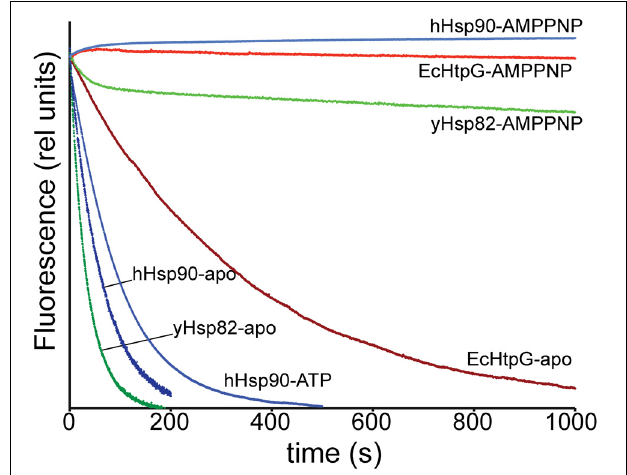
FIGURE 6 | Subunit-exchange rates differ significantly in Hsp90 proteins. Complexes of ATTO 488 and ATTO 550 labeled single cysteine variants of EcHtpG (red), yHsp82 (green) and hHsp90 (blue) were rapidly mixed with a 10-fold excess of unlabeled protein in the absence of nucleotide (dark colors) or the presence of ATP or AMPPNP as